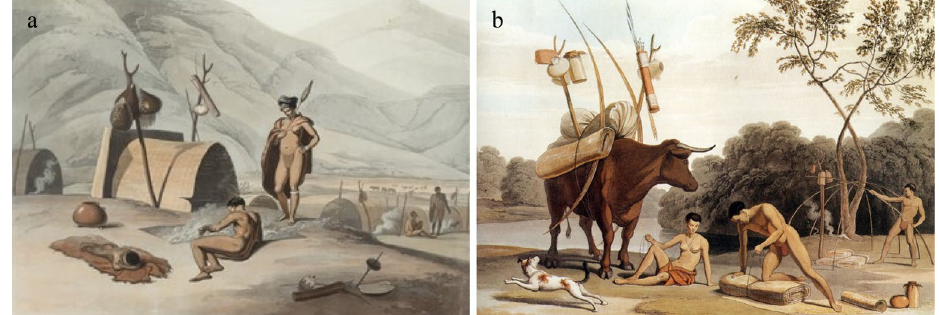
Figure 2. ( a ) ‘ Bosjesmans Frying Locusts’ painted by Samuel Daniell depicting a forager camp with a lugged ceramic vessel. ( b ) ‘ Korah Preparing to Remove ’ painted by Samuel Daniell depicting a “forager-type” bowl in a herder camp being prepared for moving. Distributed under a CC-BY 2.0